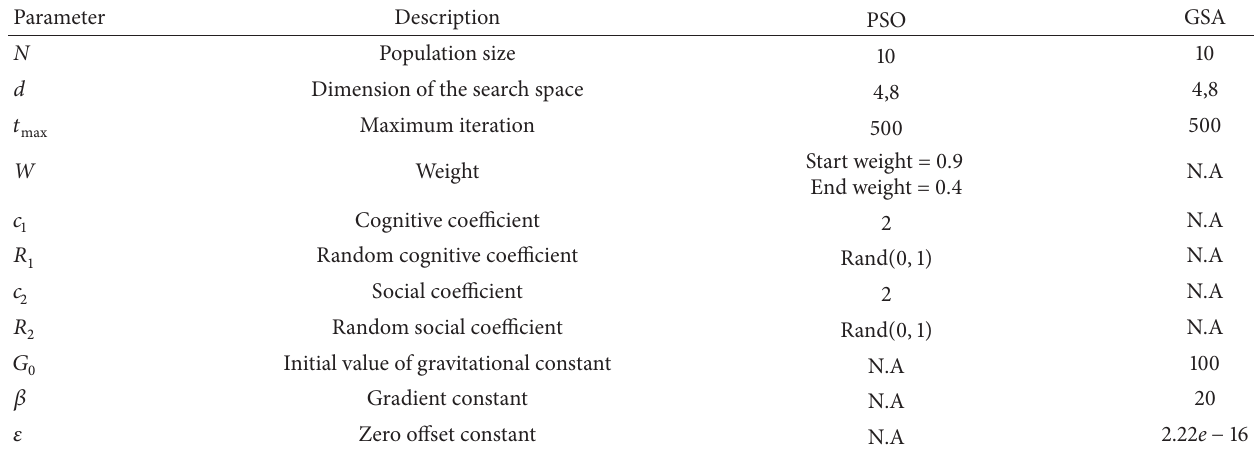
Table 1: Used parameters of PSO and GSA briefly in this